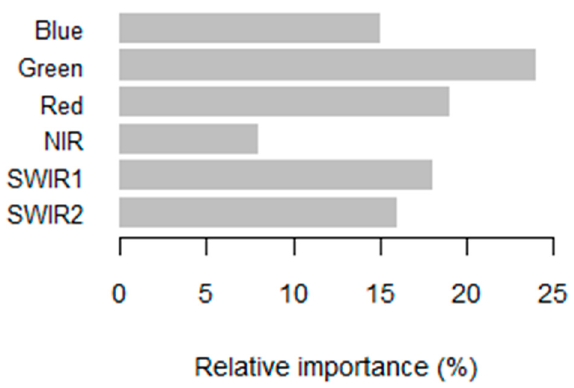
Figure 5. The relative importance of each variable in predicting fractional woody cover.